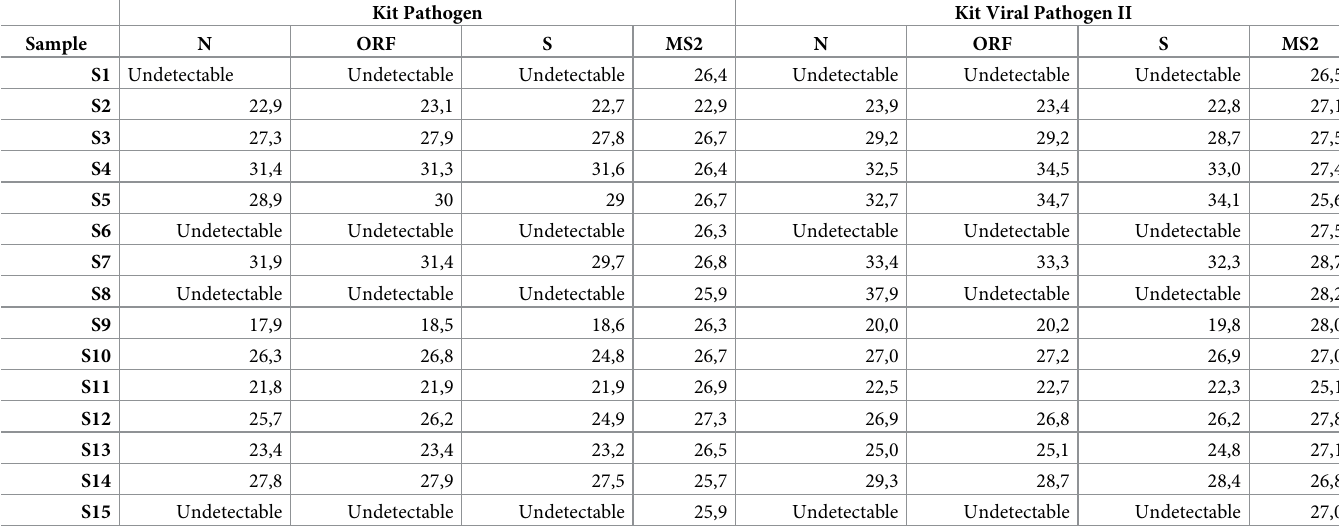
Table 4. Comparison of fifteen samples using the two automated circuits implemented in our lab using Thermo Fisher kits: OT2-KF pathogen and OT2-KF Viral Pathogen II. Kit Pathogen